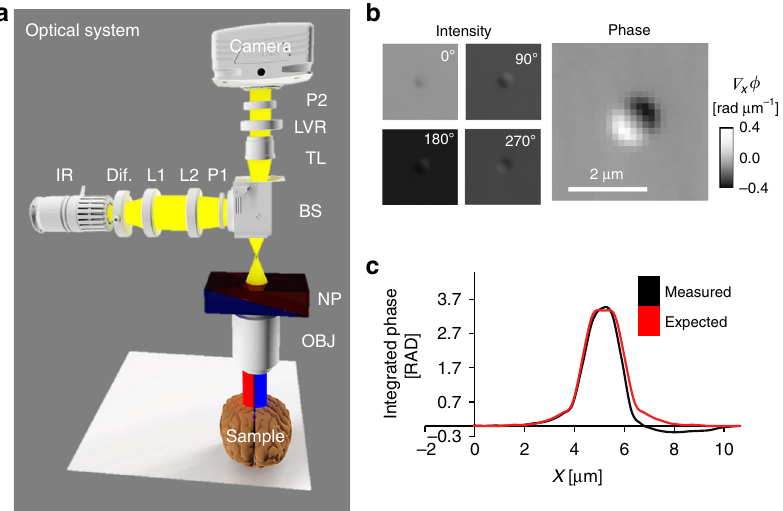
Fig. 1 Epi-GLIM enables phase imaging of opaque structures. a The epi-GLIM module intercepts the sheared beams in re fl ected light DIC (blue/red) before they are recombined at the output analyzer (P2). Speci fi cally, we focus light from an IR source through a diffuser (Dif.) by way of lenses L1, L2, beam splitter and objective (L1, L2, BS OBJ). To achieve differential interference contrast, the light is polarized by an input polarizer (P1) and split with a Nomarski prism into two laterally sheared polarizations (NP). The backscattered fi eld is then collected by the objective and tube lens (TL). By using a liquid crystal variable retarder (LVR), we control the relative phase shifts between these polarizations. Rendering performed in Blender. b We reconstruct a relief style phase map using a sequence of DIC intensity frames acquired at 0°, 90°, 180°, 270° phase shift, as indicated. c To validate our approach, we imaged a 1.9 μ m bead on a re fl ective surface. Upon integration, we recover the expected phase pro fi le for a polystyrene bead blurred by the impulse response of the system (40×/0.75 490 nm), which is twice the value as expected in a transmission geometry. The slight mismatch on the right lobe motivates the use of a